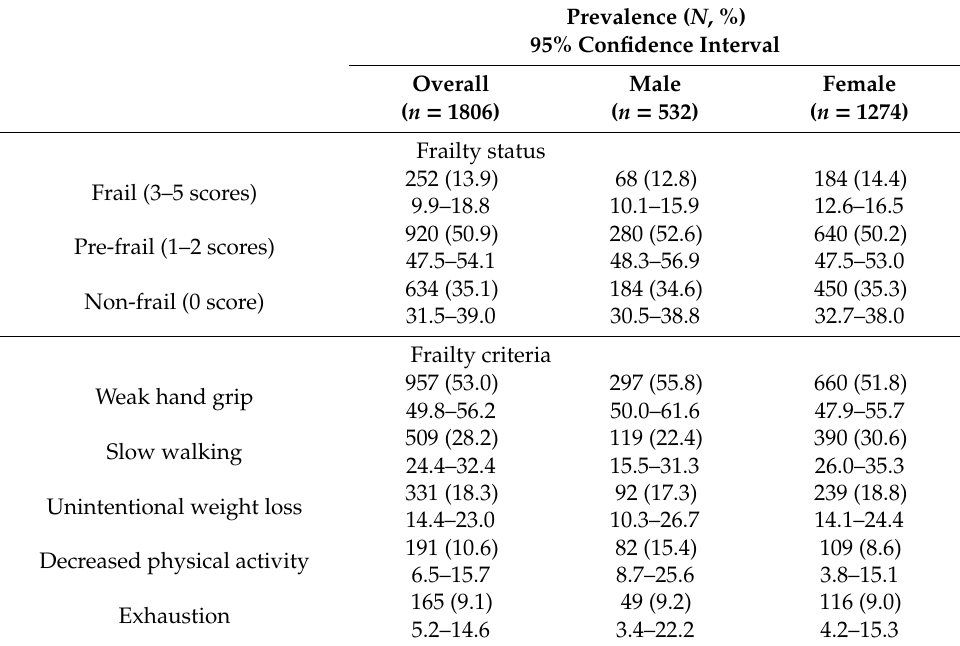
Table 1. Prevalence and 95% CI of frailty status and each presenting frailty criterion.